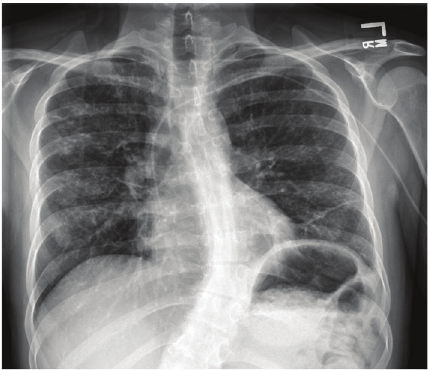
Figure 3: Chest radiograph taken two weeks after discharge from the hospital shows marked improvement of pleural and parenchy- mal disease. Central line for infusion of antibiotics is